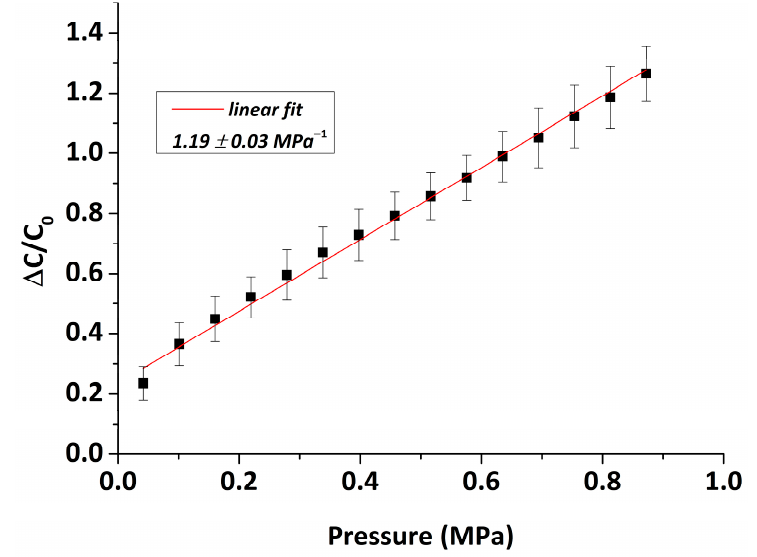
Figure 6. Average relative capacitance variation of 16 sensors as a function of the external pressure applied (0.04–0.87 MPa); the red line represents a linear fit of slope 1.19 ± 0.03 MPa − 1 .